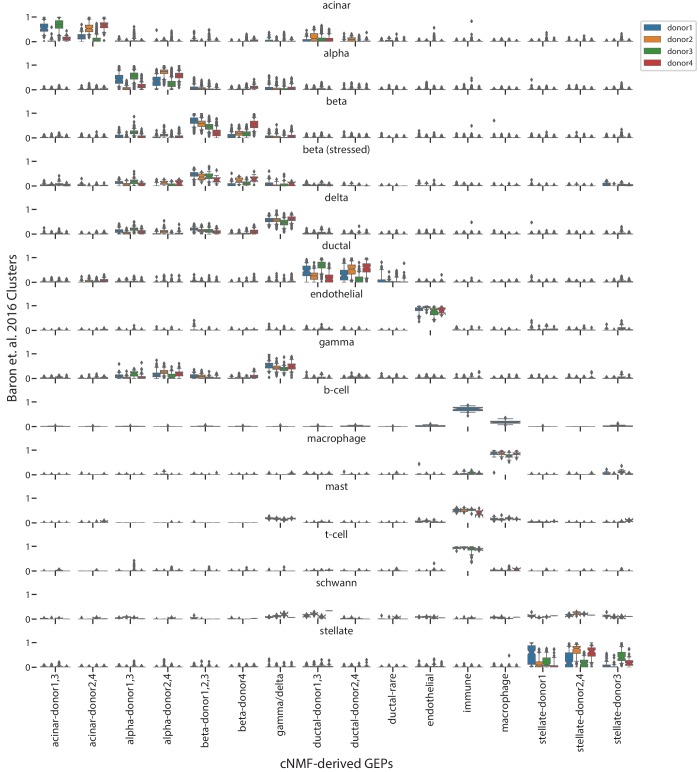
Comparison of cNMF usages with the published cell-type clusters from Baron et al. (2016).Box and whisker plot of the usage of each GEP (column) in cells of each cluster from Baron et al. (2016) (rows) stratified by the donor of origin of each cell (hue). Boxes represent interquartile range, whiskers represent 5th and 95th percentiles.